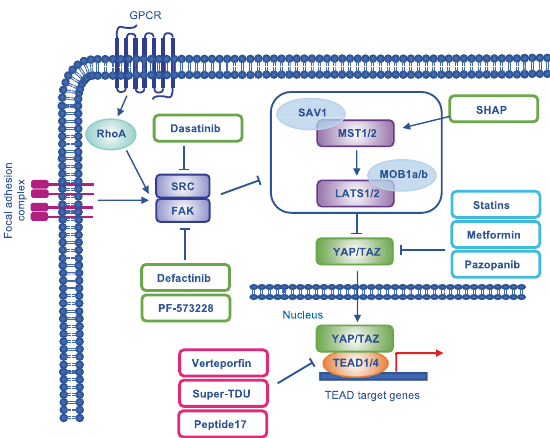
Fig. 5 Drugs targeting the Hippo pathway. Hippo-targeted drugs act at different levels of the signaling cascade: some of them directly target the YAP-TEAD complex (red squares), while others inhibit YAP/TAZ nuclear localization (sky blue squares) or act at the level of upstream regulators, mainly linked to mechanical cues (green